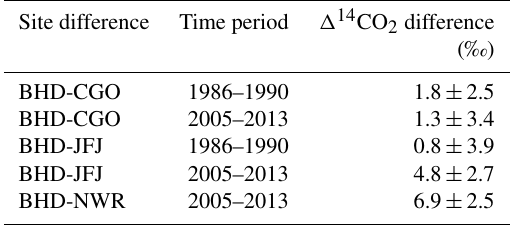
Table 2. (cid:49) 14 CO 2 gradients between sites, determined as the mean of the monthly differences for each time period. Errors are the stan- dard deviation of the monthly differences.